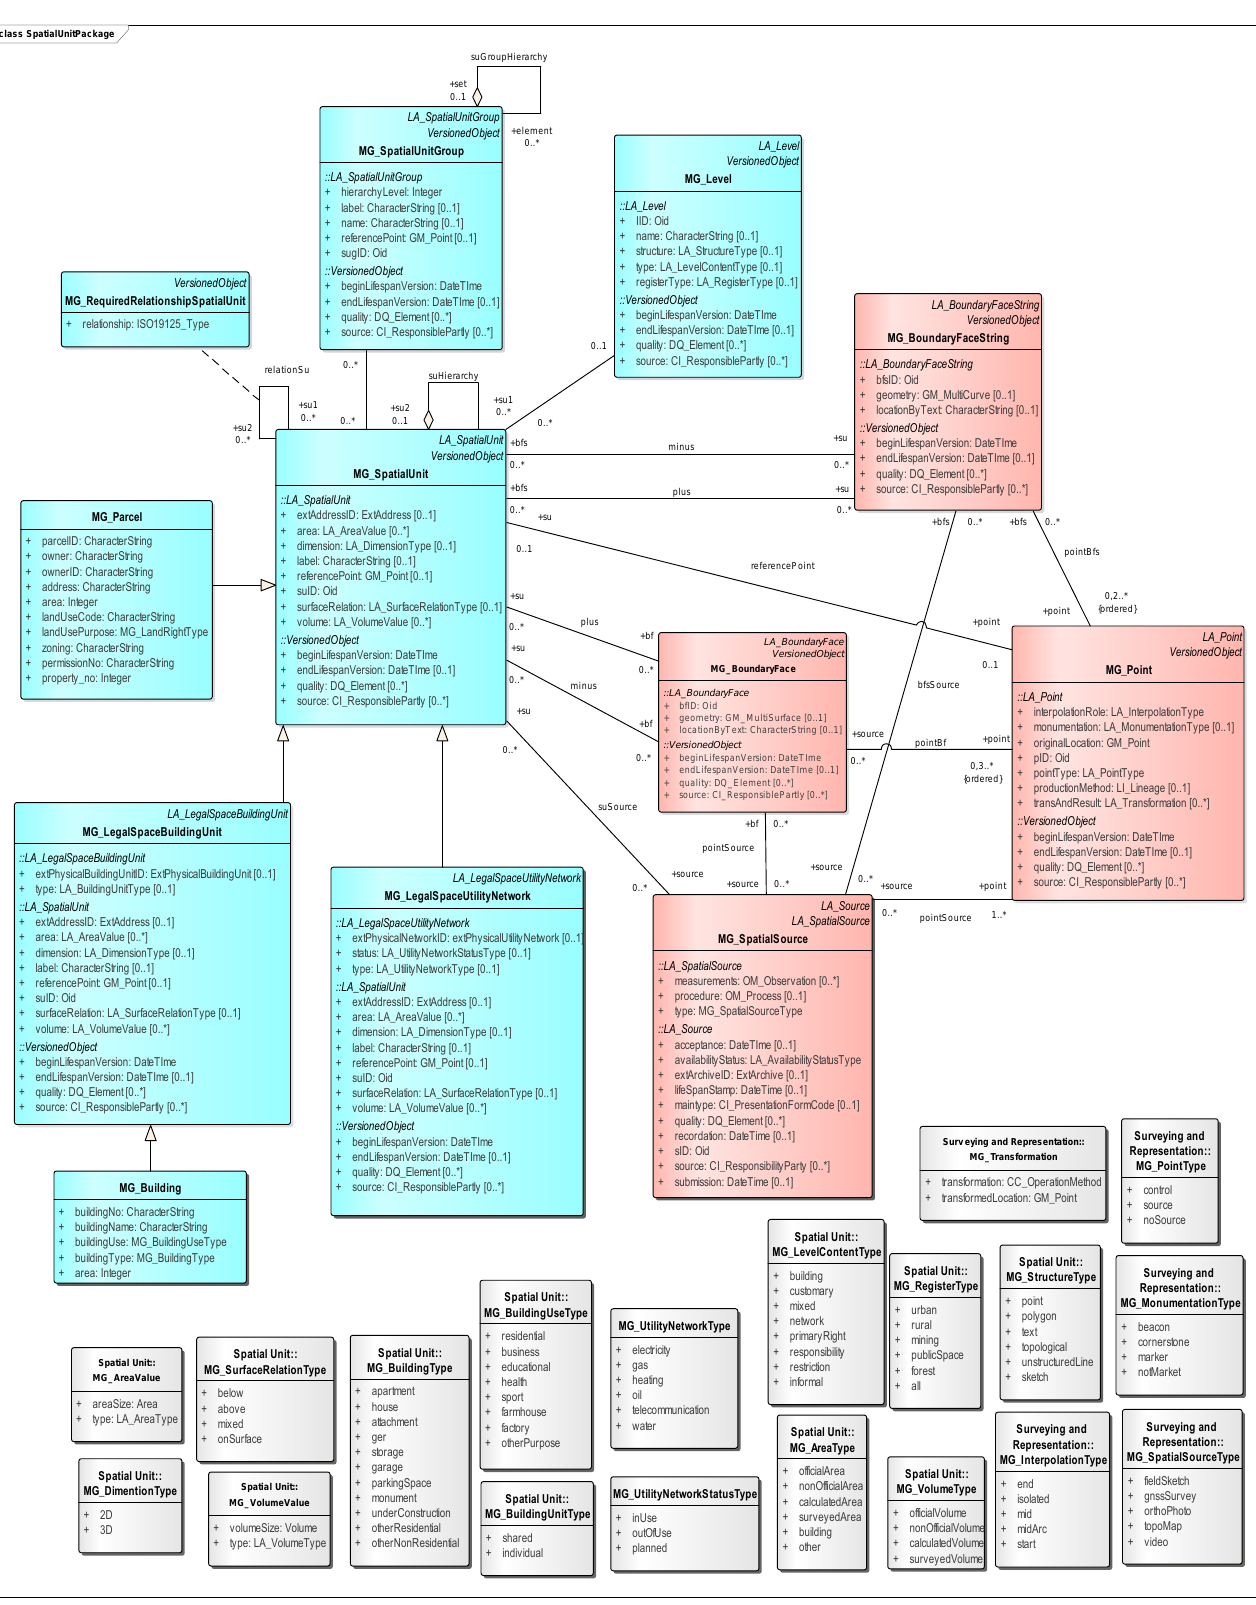
Figure 8. Spatial (Spatial Unit and Surveying and Representation Subpackage) part of the Mongolian LADM Profile.